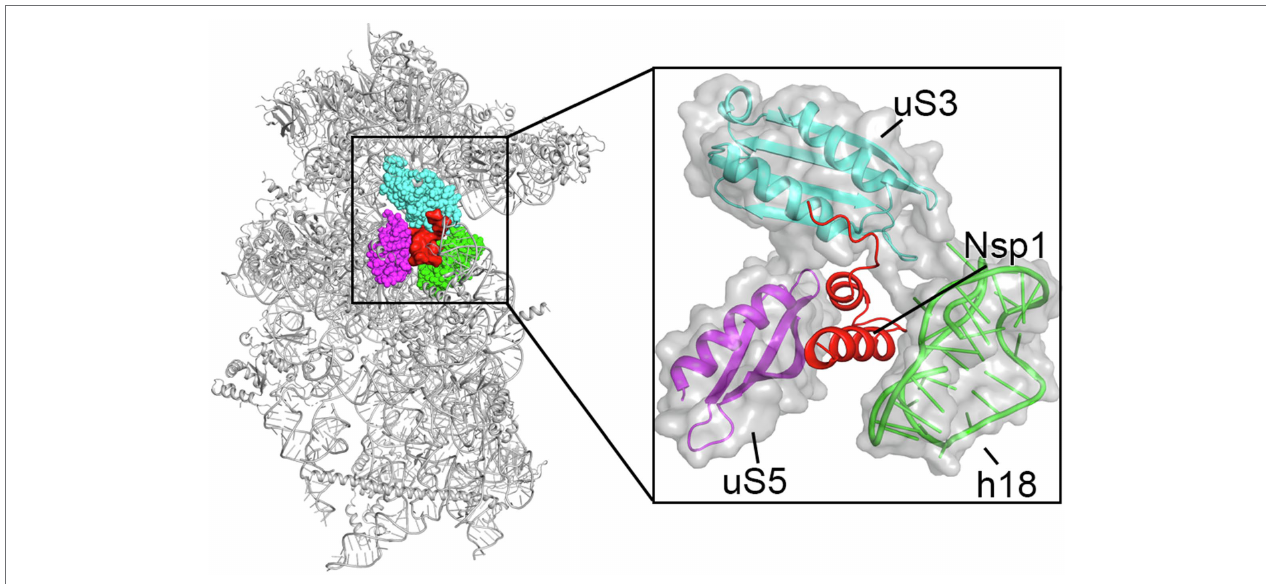
FIGURE 4 | Cryo-EM structure of the Nsp1 C-terminal region-40S ribosomal subunit complex, with Nsp1 (red surface) and the surrounding protein uS3 (cyan sphere representation), uS5 (magenta) and rRNA h18 (green) highlighted. The inset shows zoomed-in view of Nsp1 in cartoon, with the surrounding 40S components in cartoon and surface to illustrate the mRNA entry